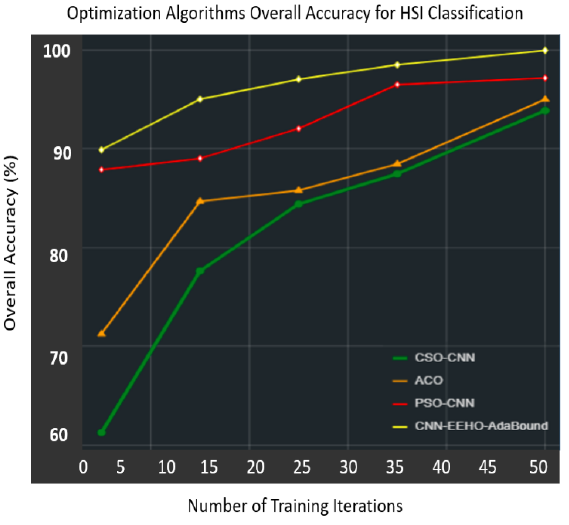
Figure 9. Overall accuracy for optimization algorithms .